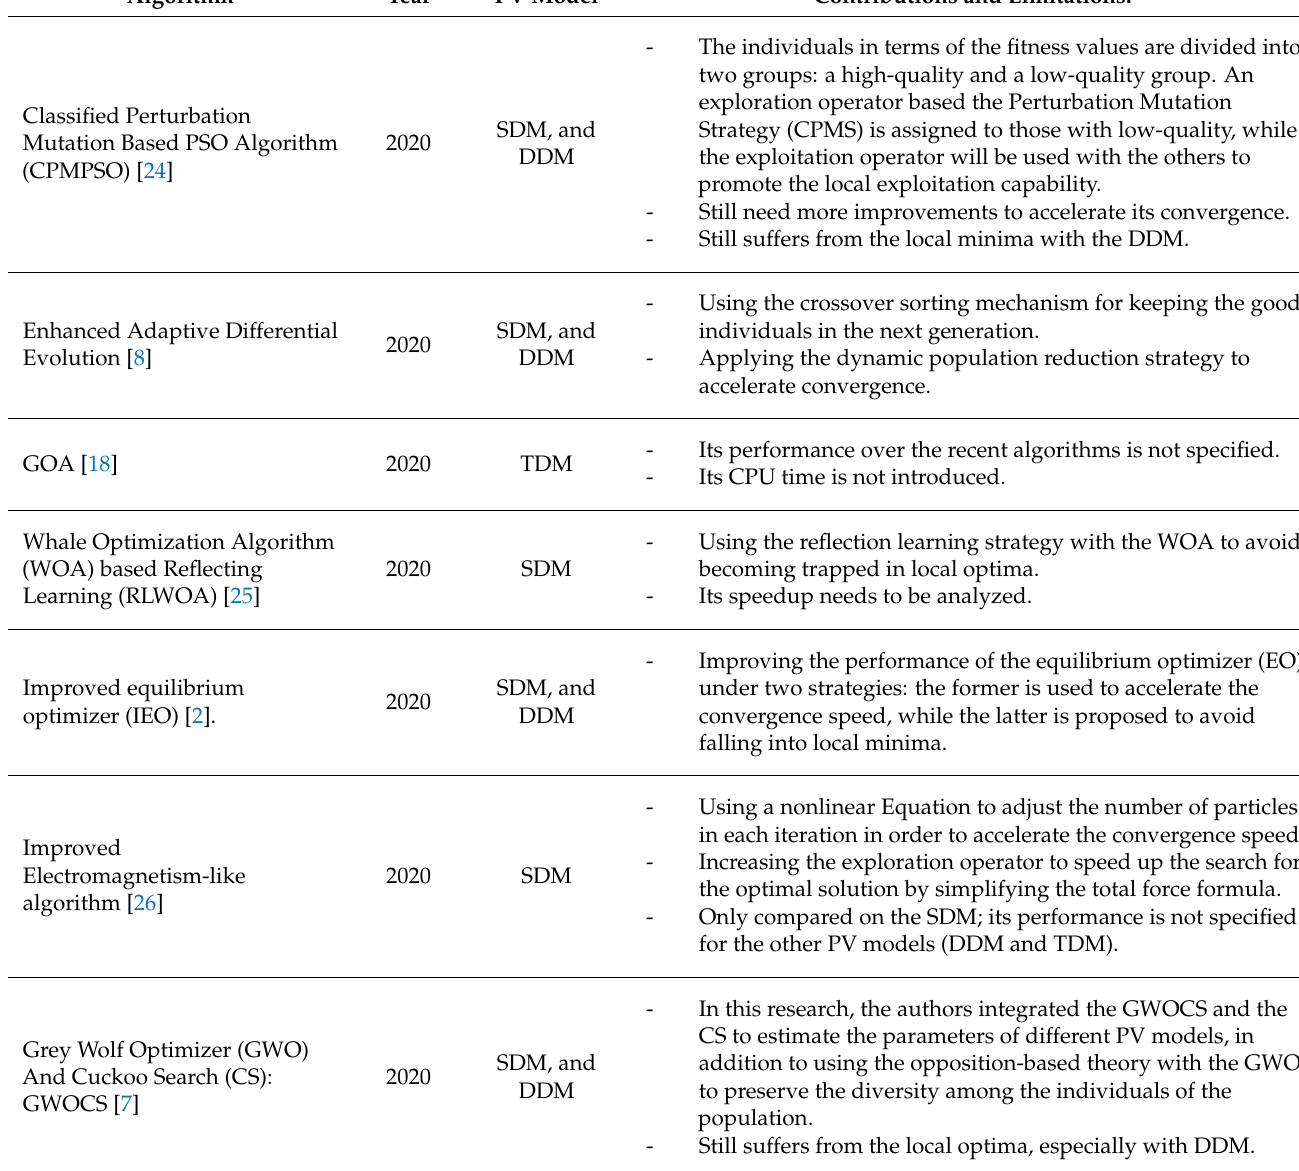
Table 1. Survey of the existing state-of-the-art algorithms for parameter estimation of different PV models.